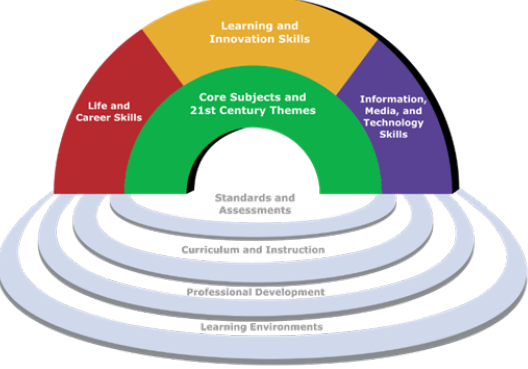
Source: Trilling & Fadel,